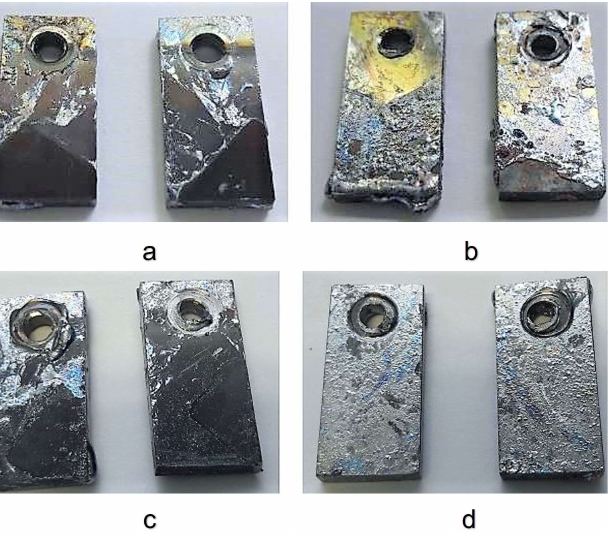
Figure 10. Optical images of the 316L stainless steel samples: coated ( a , c ) and uncoated ( b , d ) after 500 h ( a , b ) and 1000 h ( c , d ) of testing in liquid lead.